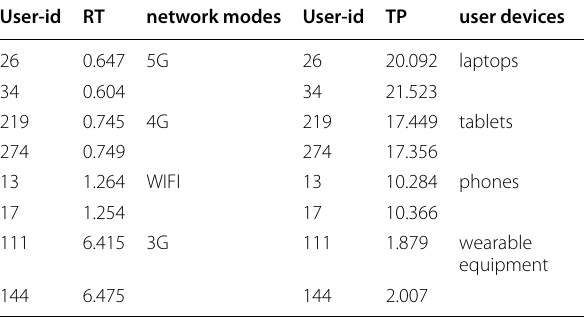
Table 2 Service quality of some users with different devices User-id RT